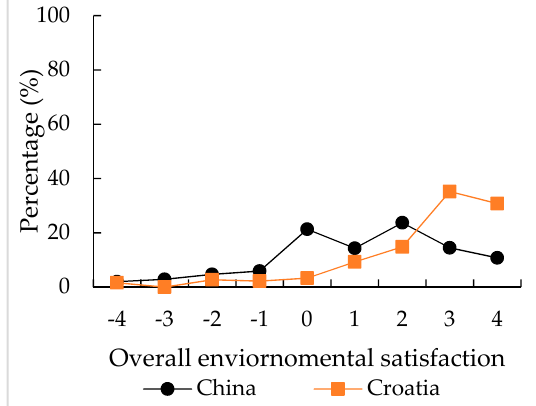
Figure 1. Sound satisfaction of public open spaces in China and Croatia. Figure 2. Environmental satisfaction of public open spaces in China and Croatia.